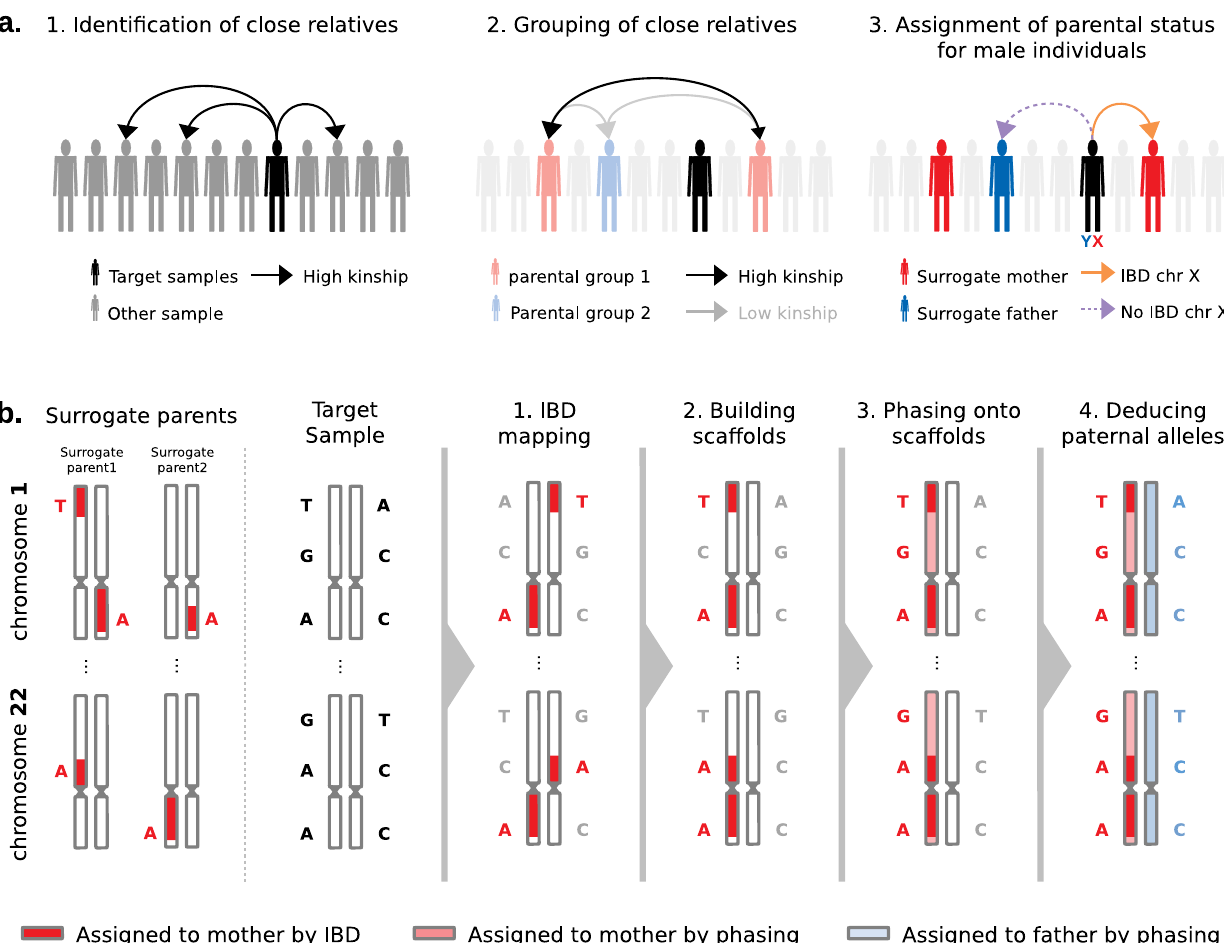
Fig.1|RationaleofPofOinference.a Identi fi cationofsurrogateparentsin3steps: (1)identi fi cation of close relatives fora target sample of interestusing the pairwise kinship estimates, (2) clustering of close relatives by maximizing and minimizing the inter- and intra-groups relatedness, respectively, (3) assignment of parental status to close relatives ’ groups (i.e., surrogate parents) using IBD sharing on chromosome X for male targets. b Parent-of-origin inference in 4 steps: (1)